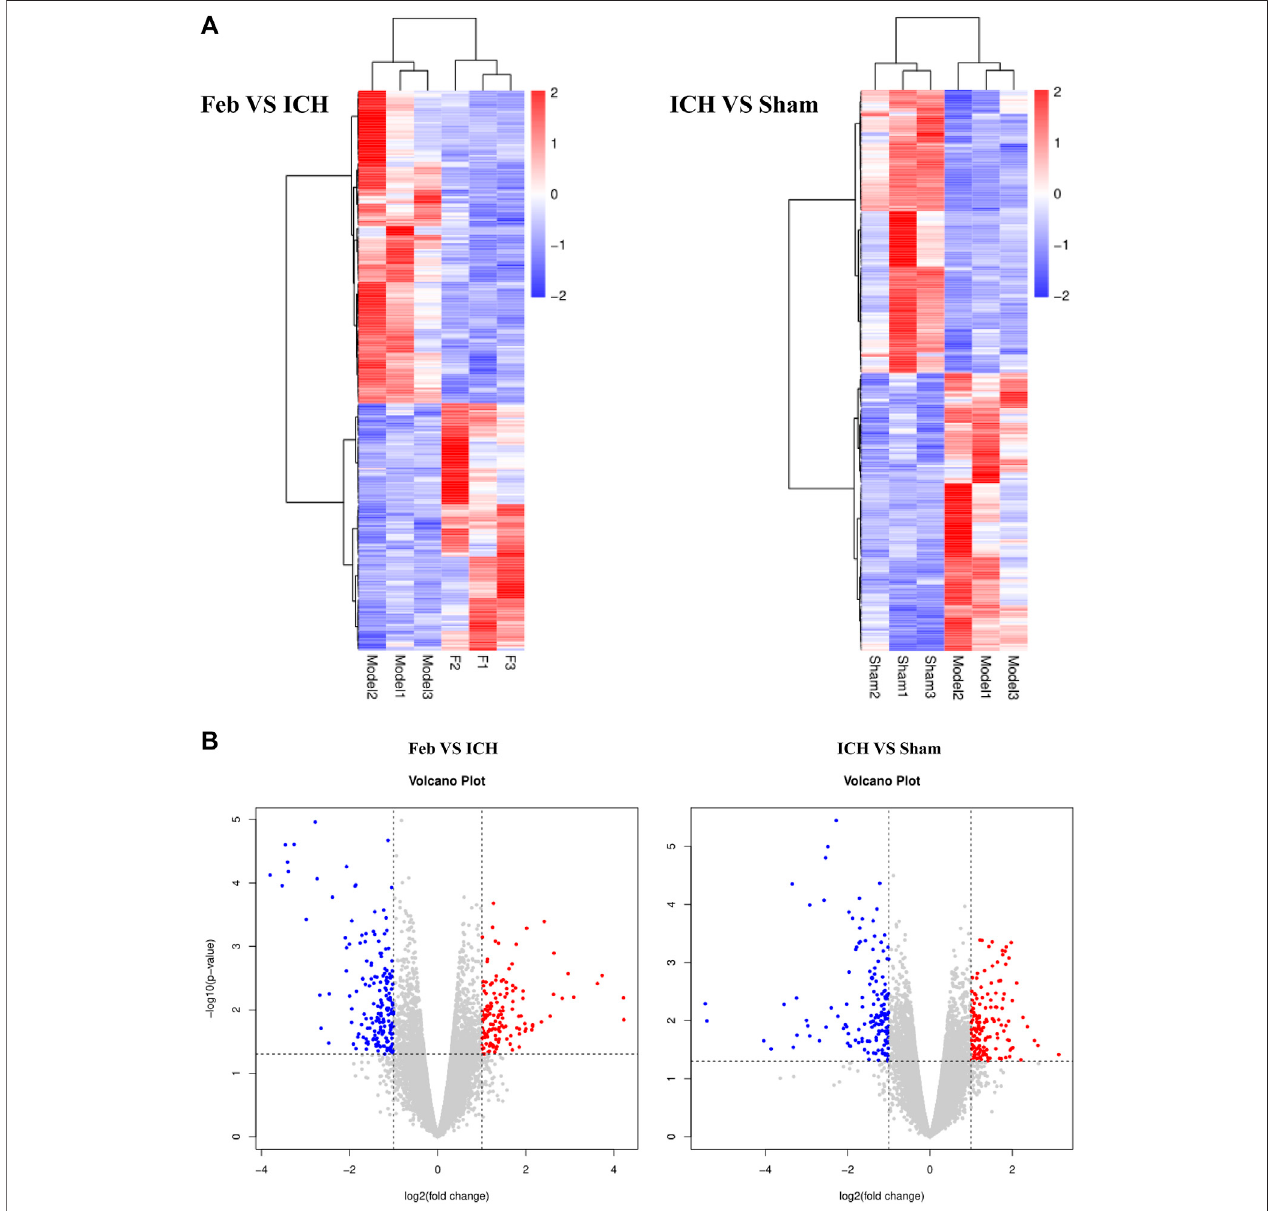
FIGURE4| HierarchicalclusteranalysisofDEGs: (A) HierarchicalclusteranalysisshowedthattheDEGsultimatelyclusteredintotwomajorbranches:upregulated genes (labeled in red) and downregulated genes (labeled in blue). (B) Volcano plot of DEGs. The red and blue points in the plots represent the signi fi cantly upregulated and downregulated DEGs. n = 3